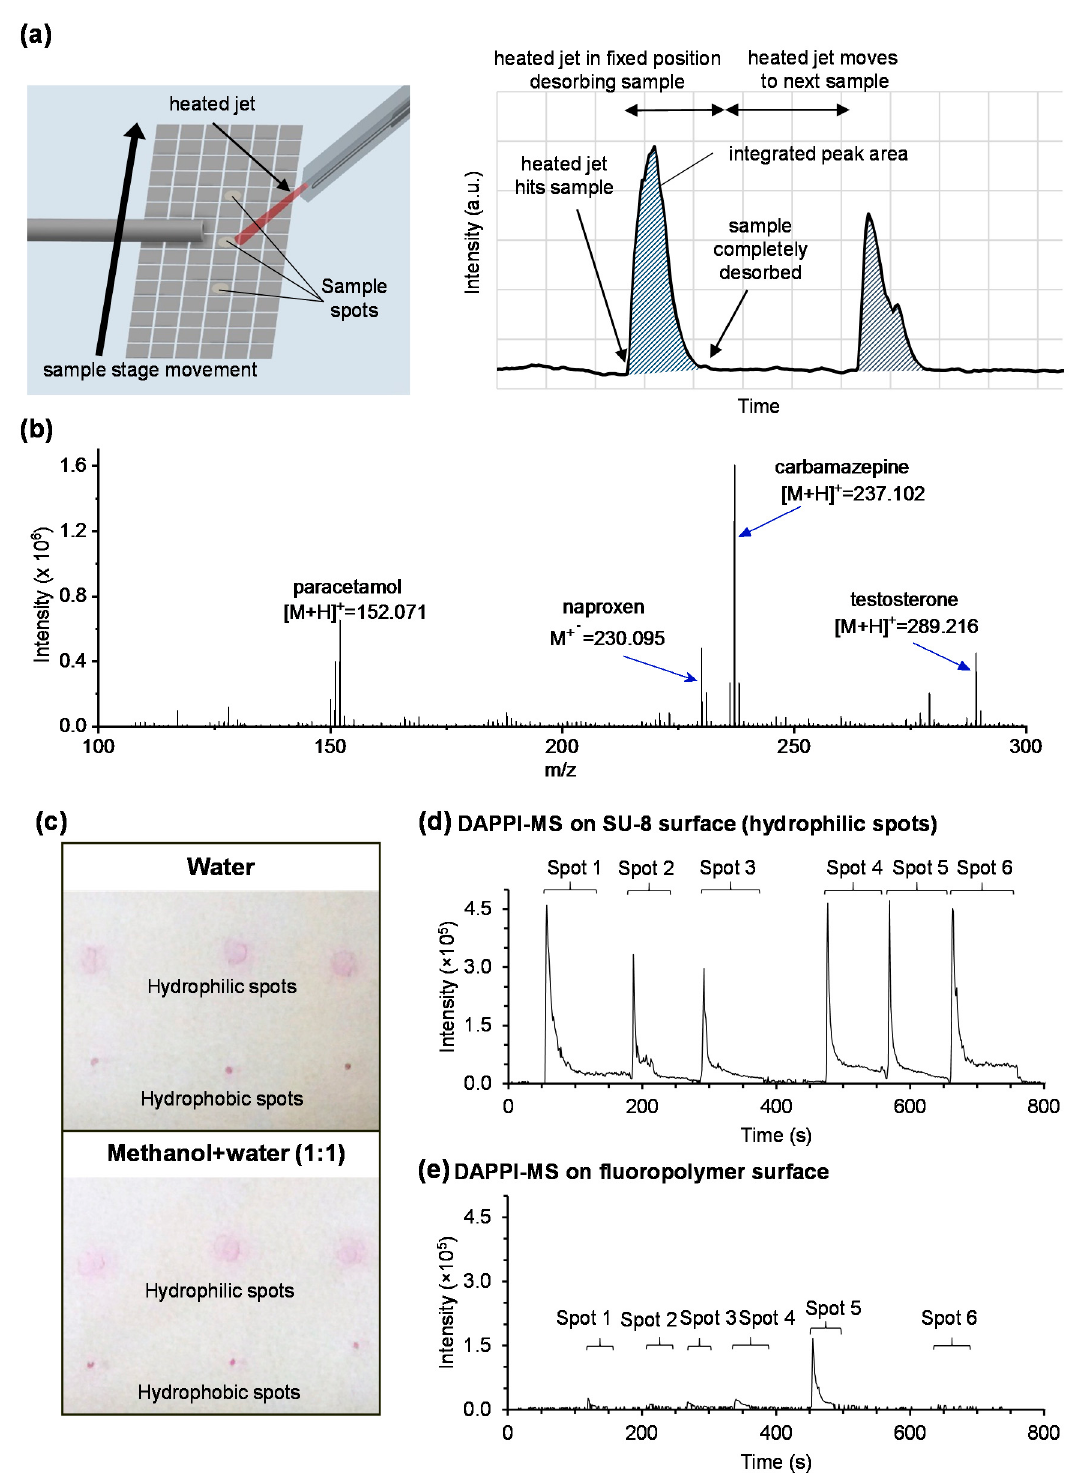
Figure 3. ( a ) Schematic illustration of the process of ( a ) desorption/ionization of samples from DMF chip surface, and integration of peak area of extracted ion chromatogram (EIC) in DAPPI-MS analysis. ( b ) Mass spectrum of paracetamol (66 pmol), naproxen (44 pmol), carbamazepine (42 pmol), and testosterone (70 pmol) dissolved in methanol-water 1:1, deposited onto the hydrophilic SU-8 spot, and analyzed by DAPPI-MS. ( c ) Photograph of rhodamine B precipitation pattern on hydrophilic SU-8 spots and on hydrophobic fluoropolymer in two different solvents: water (top) and methanol-water 1:1 (bottom). ( d , e ) EICs of testosterone (internal qualifier, 70 pmol in methanol-water 1:1) deposited and analyzed from parallel spots (n = 6) by DAPPI-MS: ( d ) on hydrophilic SU-8 spots, and ( e ) on hydrophobic fluoropolymer.